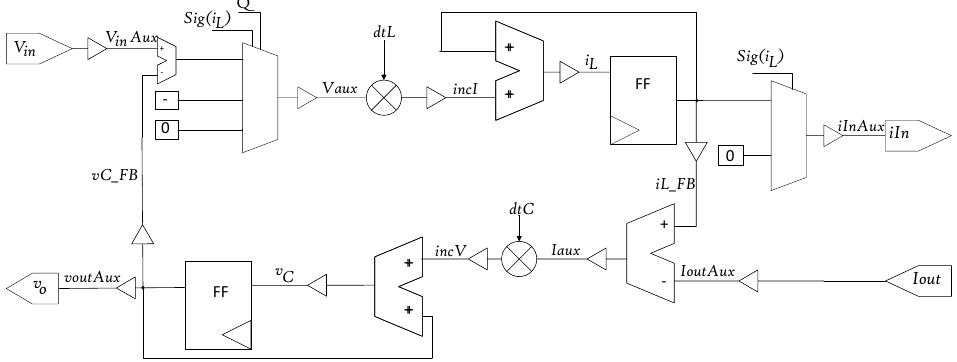
Figure 2. HIL model architecture of the buck power converter for its implementation in VHDL-2008. The OPT word-length (WL) and fixed-point format for each of the model’s signals and constants are given in Table 1. The WLs and lengths of the integer and fractional parts of each of them were determined according to the methodology proposed in [34,35]. For example, the integer part of v C should be set to the minimum number of bits that enable representing the maximum value of the signal during the transitory plus 1 extra security bit. The maximum value of v C in the transitory period (see Figure 3) lies below 10 V, then 5 bits would be enough to fully represent the integer part of v C . In contrast, the fractional part width should be selected so as to fully represent the minimum voltage increment with enough numerical resolution, IncV , during the steady-state period in absolute